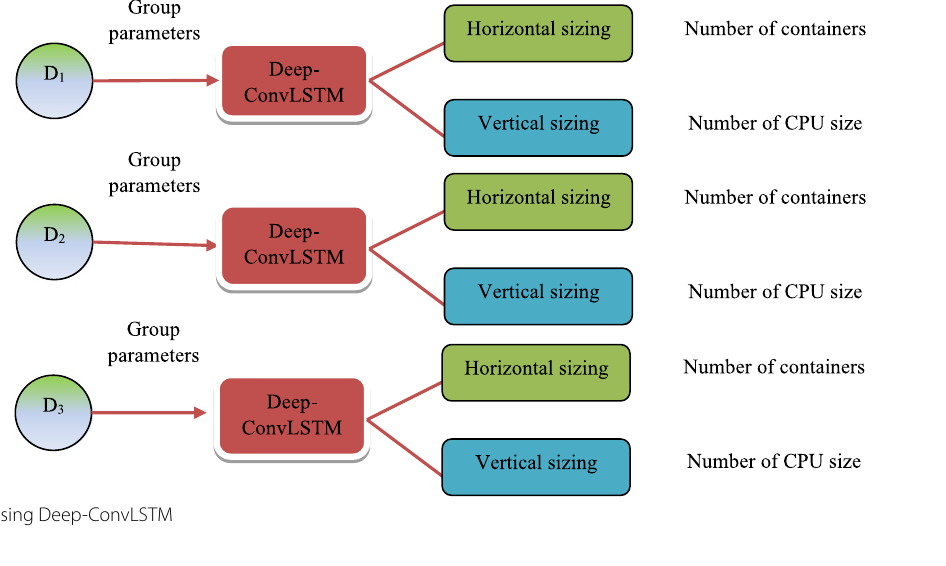
Fig. 4 VM sizing using Deep-ConvLSTM